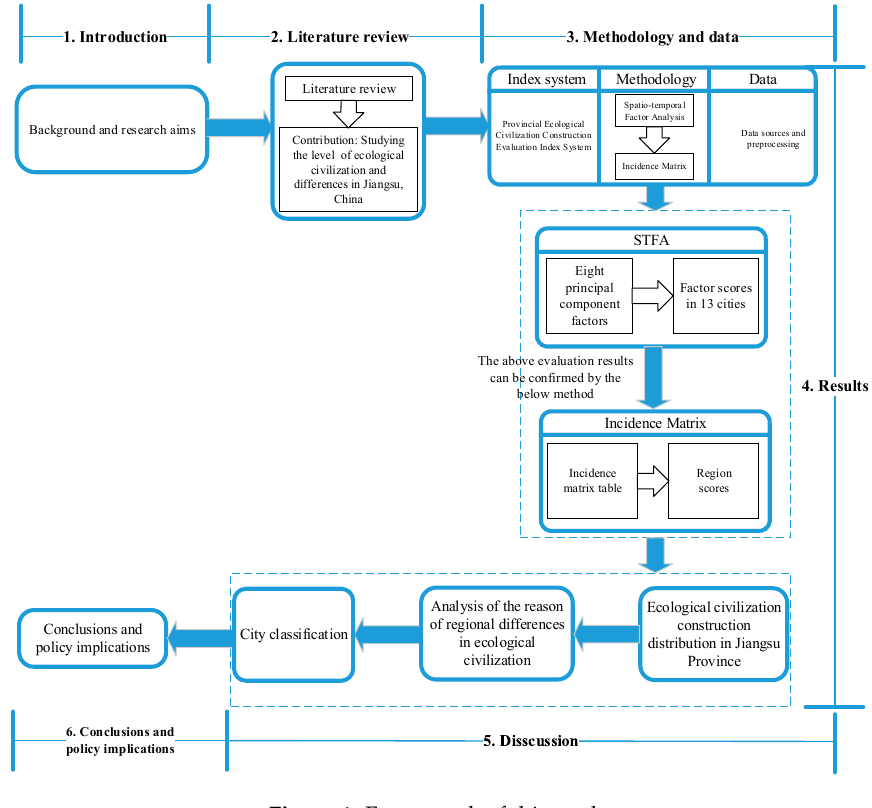
Figure 1. Framework of this study.